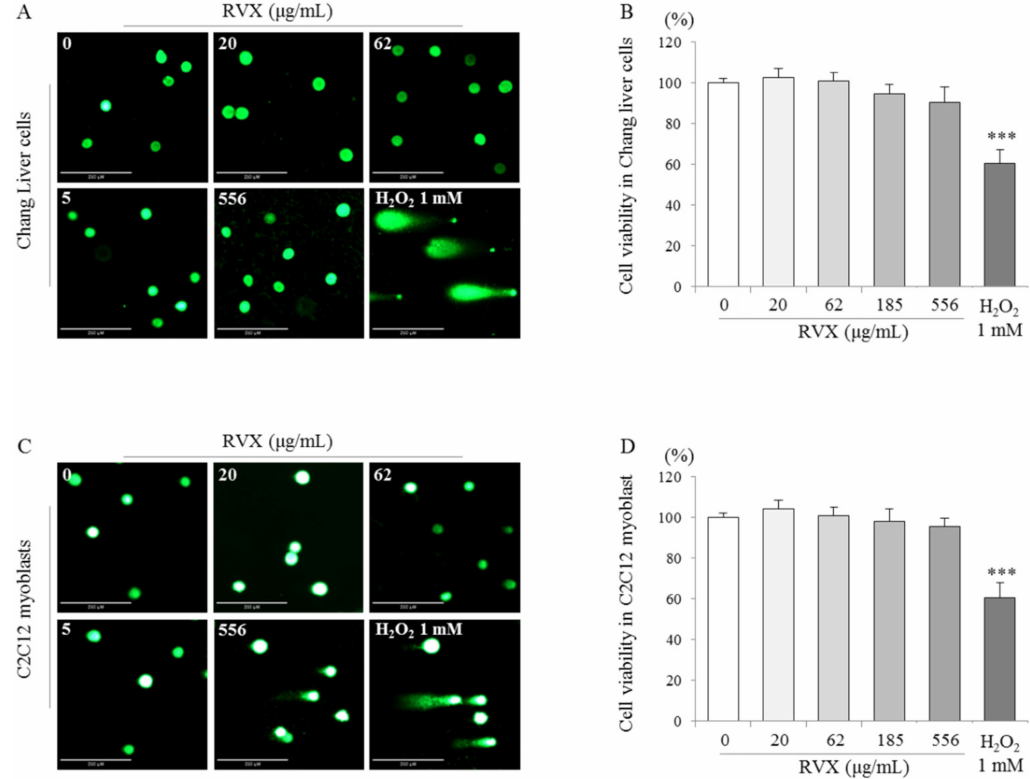
Figure 4. ( A , C ) A comet assay was performed for Chang liver and C2C12 cells after treatment with RVX for 24 h. The images stained with propidium iodide (PI) were captured under a fluorescence microscope. ( B , D ) The viability of Chang liver and C2C12 cells was determined using the MTT assay. *** p < 0.001 compared to the negative control (0 µ